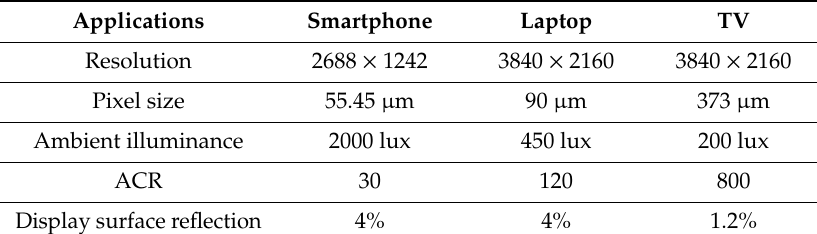
Table 2. The specifications of smartphone, laptop and TV evaluated.